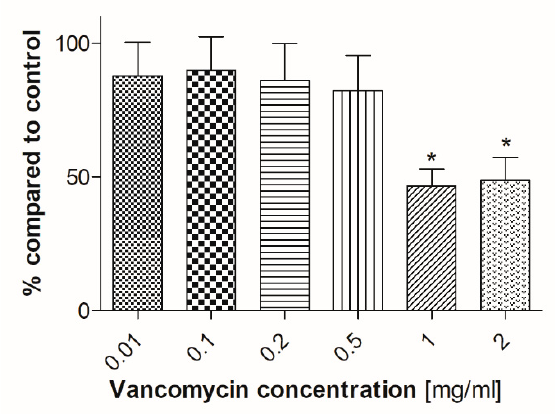
Figure 11. ALP activity of human osteoblasts after exposure to vancomycin for 5 days (* p < 0.05; ** p < 0.01; *** p < 0.001 to control). The results are presented in percentage of the control without vancomycin (100%).